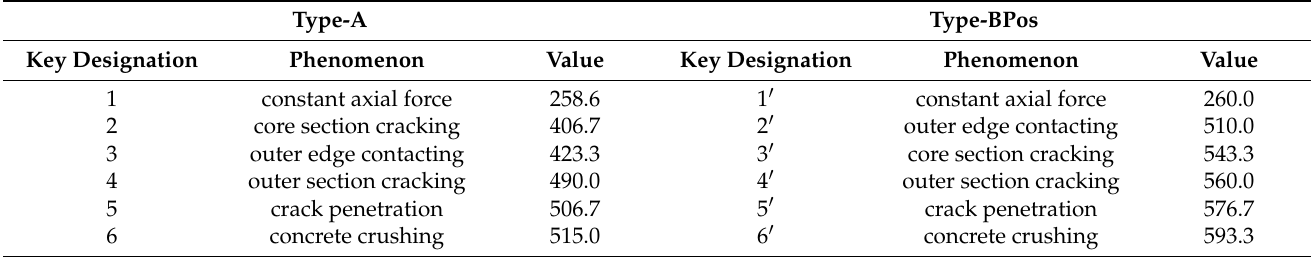
Table 2. Key moments during the damage processes in positive cases (unit: kN·m/m).